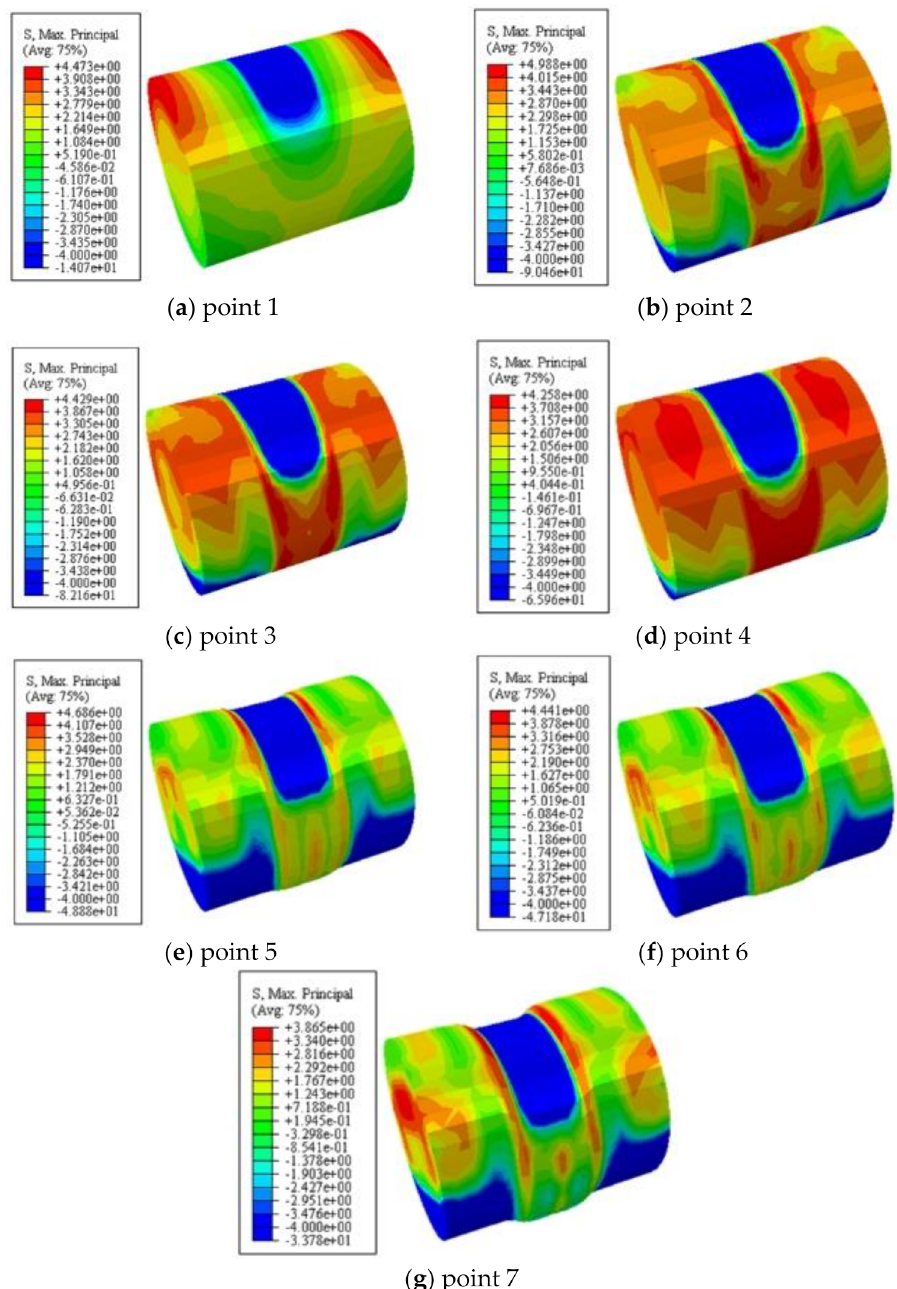
Figure 12. The maximum principal stress of